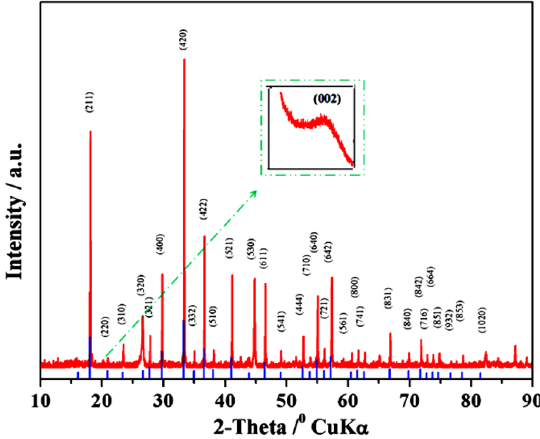
Figure 3. XRD patterns of C 12 A 7 − x Fe x :e − samples (x = 1).